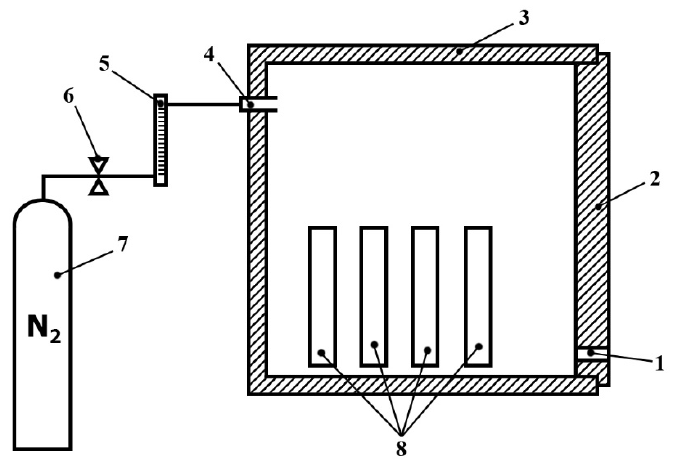
Figure 1. The schematic of the sample preparation device: 1—gas exhaust; 2—furnace door; 3—muffle furnace; 4—nitrogen supply; 5—volumetric flow meter; 6—reducing valve; 7—nitrogen supply tank; 8—samples.